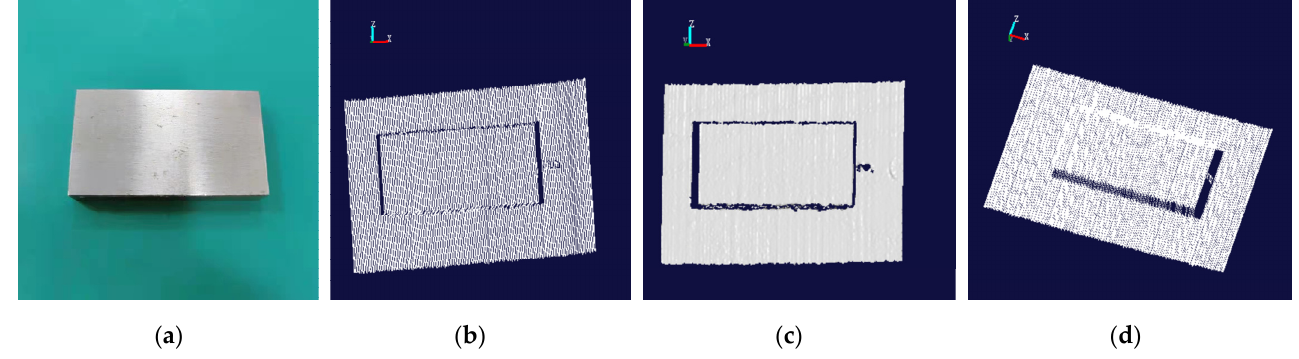
Figure 20. The related images of the standard gauge block. ( a ) The original image. ( b ) The point cloud image based on binocular camera positioning. ( c ) The rendering image based on ( b ). ( d ) Point cloud image based on robot positioning.